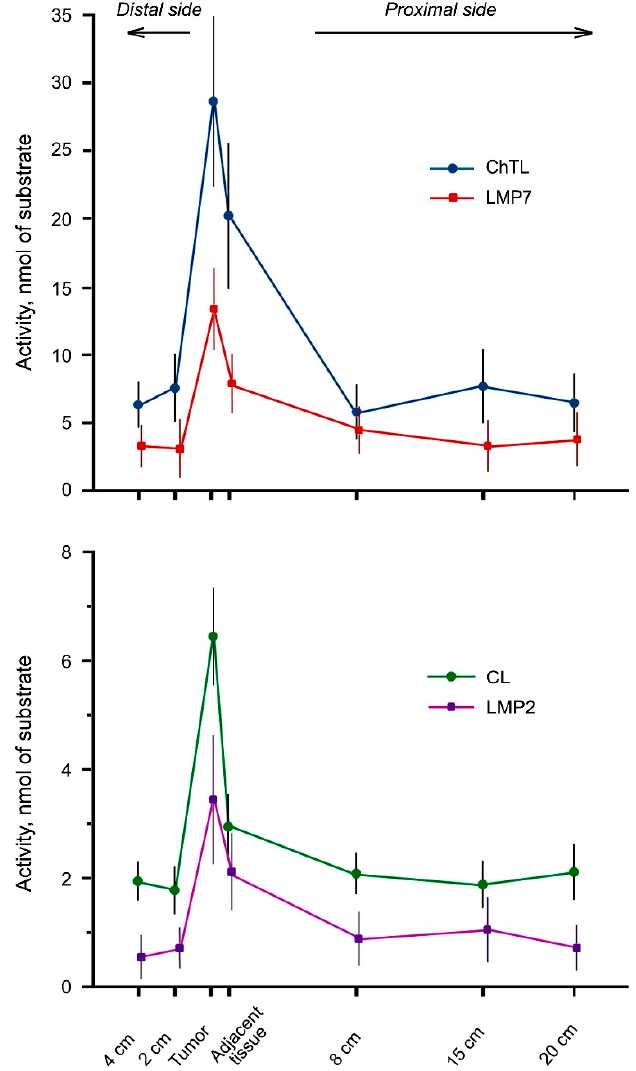
Figure 1. Proteasome ChTL, CL, LMP7 and LMP2 activities in rectal adenocarcinoma and different intestine parts of patients. The activities are expressed in nmol of substrate, hydrolyzed by 100 μ L of clarified homogenate for 20 min. Standard deviation is shown as whiskers. The activities in the tumor and adjacent tissue differ reliably from the activities in other intestine locations at p < 0.001.